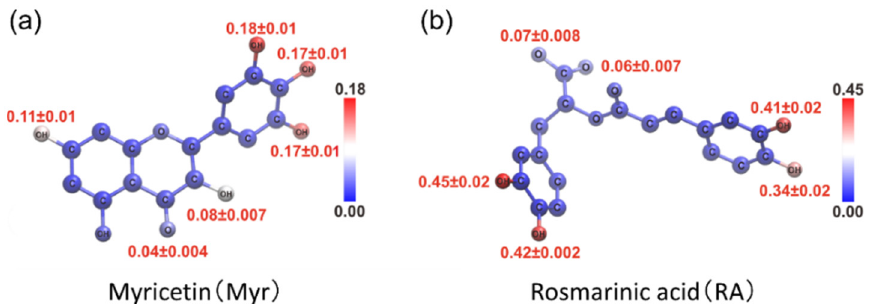
Figure 13. Color mapping of contact probability of the ( a ) myricetin and ( b ) rosmarinic acid atoms with the A β (16–22) peptide at 300 K. Reprinted with permission from Reference [26]. Copyright 2020 Elsevier.